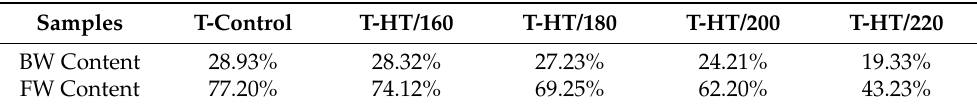
Table 4. The content of BW and FW of the wood samples after 60 days of water absorption in the T direction.